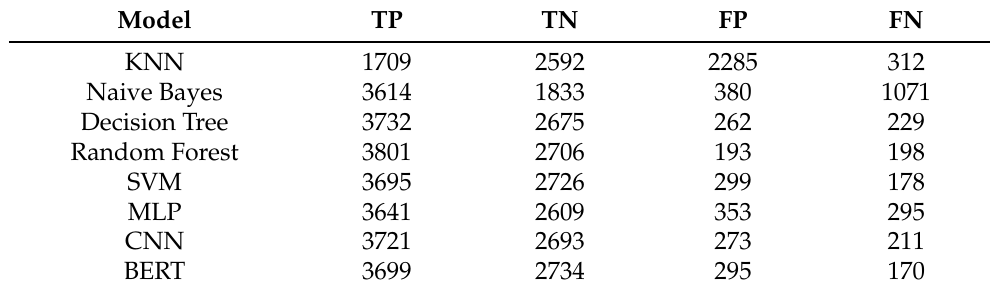
Table 2. Confusion matrix of each